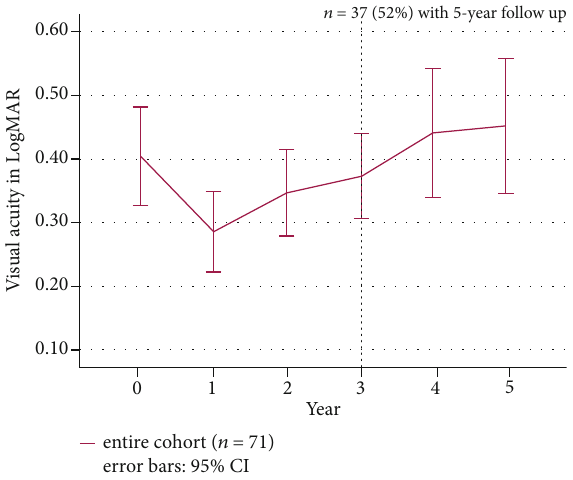
Figure 2: Mean visual acuity changes in logMAR from baseline to fi fth year. Purple line represents the entire cohort ( n = 71 until year 3). 4-year and 5-year data were available from 37 patients (dotted line). The 95% con fi dence interval is shown as error bars. Mean VA improved most in the fi rst year. Improved mean VA was maintained until year 3. After 4 years, mean VA was worse than baseline VA despite continued